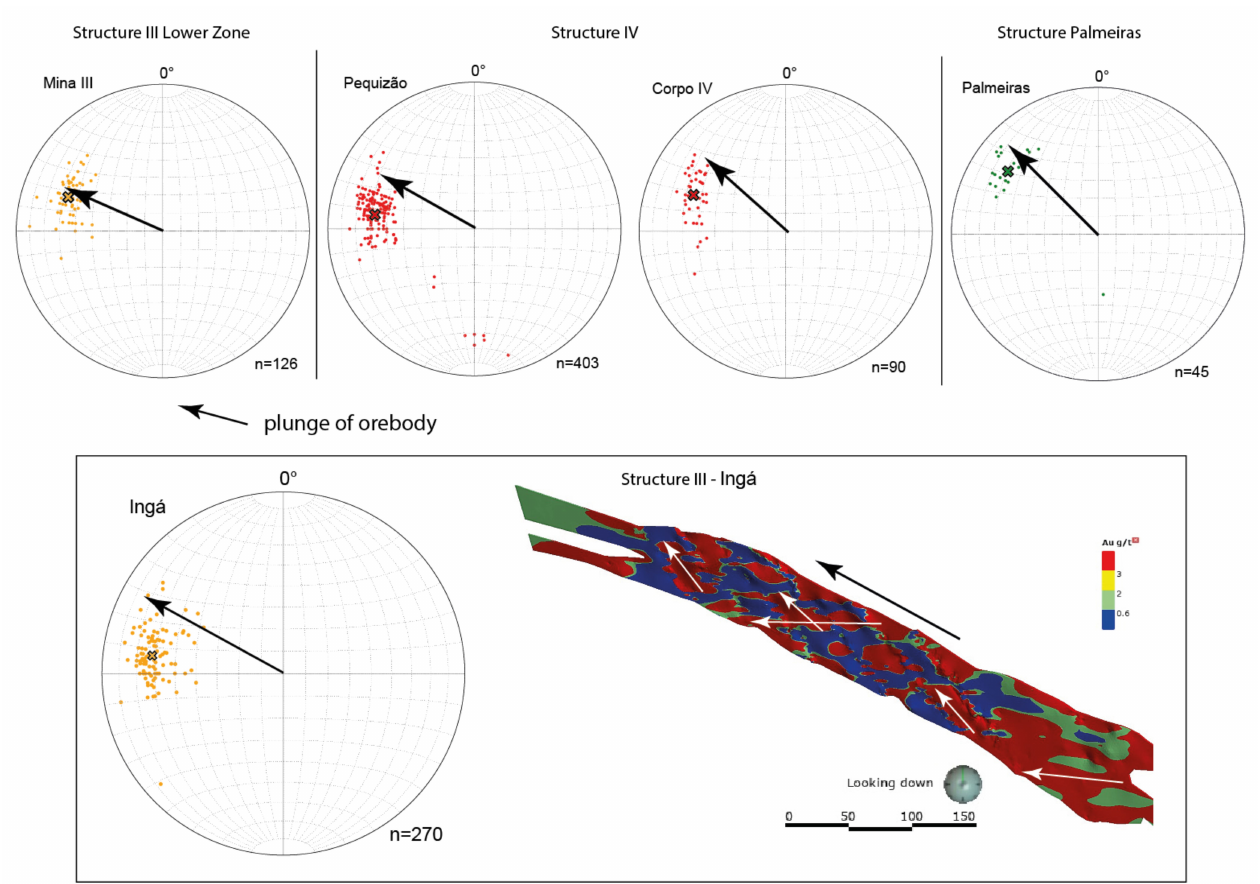
Figure 9. Stereoplots of linear structural data distribution within presented orebodies. Lineations and Fisher mean trend and plunge (cross) in stereoplots are color-coded as follows: Structure III Lower Zone—yellow, Structure IV—red, Structure Palmeiras—green. Arrows represent the trend and plunge of orebodies (black) and oreshoots (white) as calculated in Leapfrog. The bottom figure shows the result of the modelling of oreshoots within the Ing á